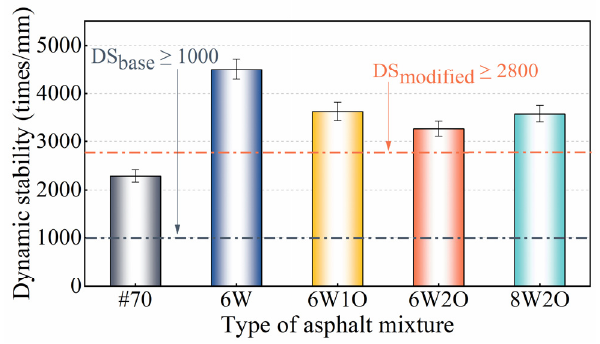
Figure 5. Test results of dynamic stability.